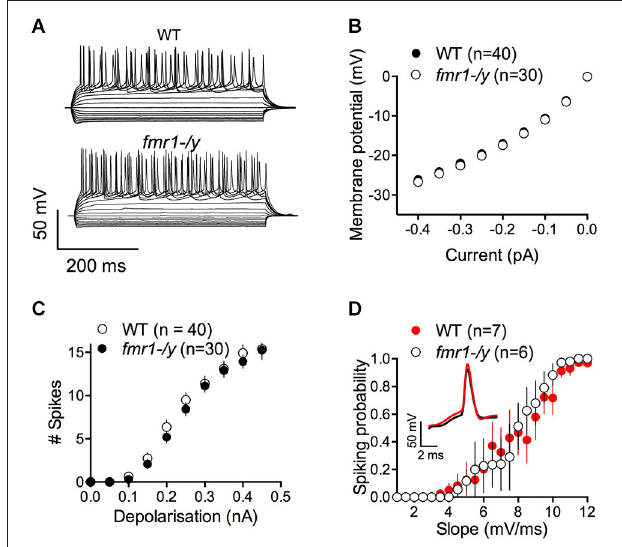
FIGURE 3 | Similar excitability profile in wild-type and fmr1-/y medium spiny neurons . (A) Representative traces of voltage responses to somatic current injections of a wild-type (upper panel, WT) and fmr1-/y (lower panel) medium spiny neuron. (B) The voltage responses to hyperpolarizing current pulses revealed no differences in input resistance or inward rectification between the two genotypes ( p = 0.2770, two way ANOVA; WT n = 40, black symbols; fmr1-/y n = 30, white symbols). (C) The number of action potentials as a function of depolarizing current injections was similar ( p = 0.1272, two way ANOVA). (D) The firing probability plotted as a function of the EPSP slope revealed no changes in the Excitation-Spike coupling ( p = 0.1488, two way ANOVA; WT n = 8, black symbols; fmr1-/y n = 5, white